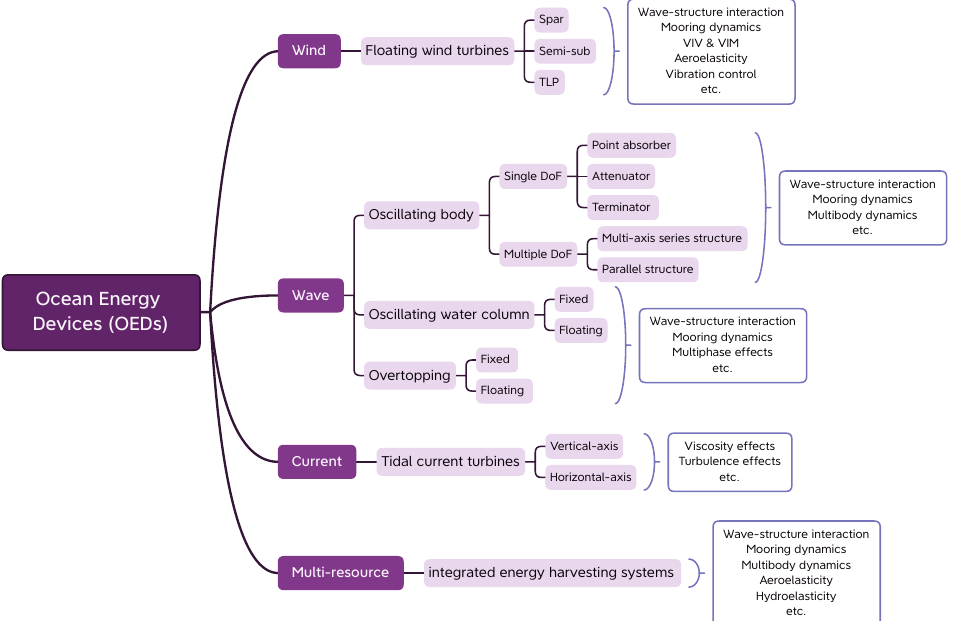
Figure 1. A popular classification of various OEDs (inspired from [13]) and the typical hydrodynamic problems associated with